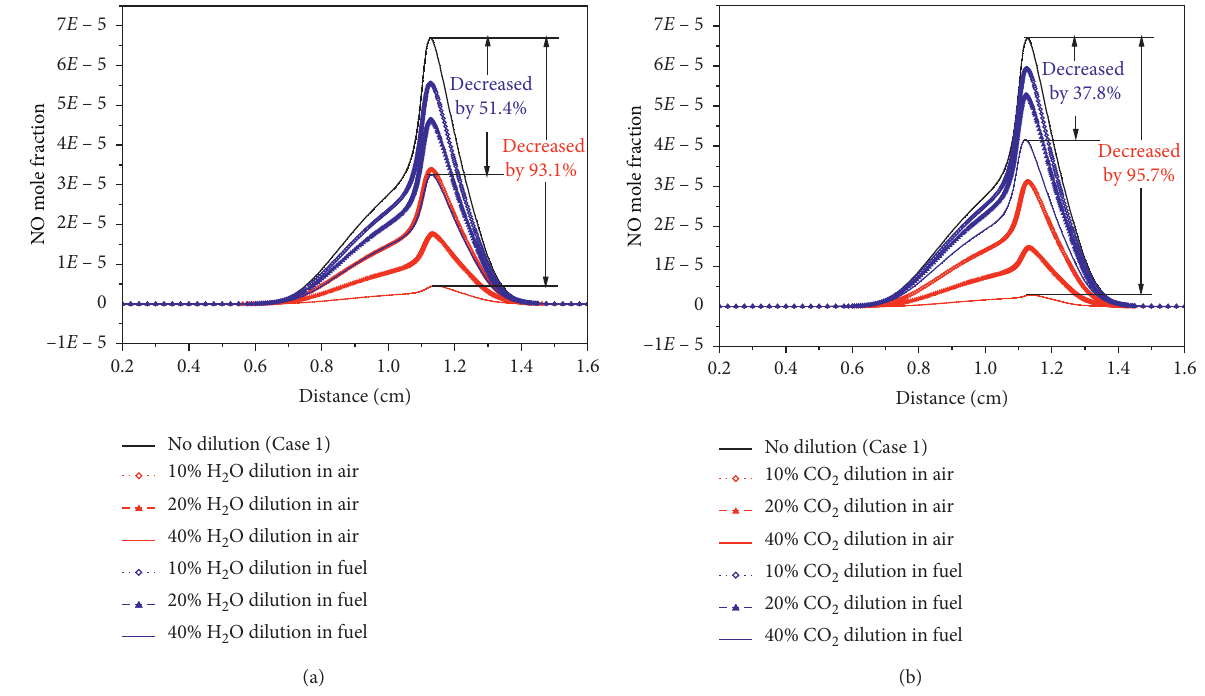
Decreased by 37.8%